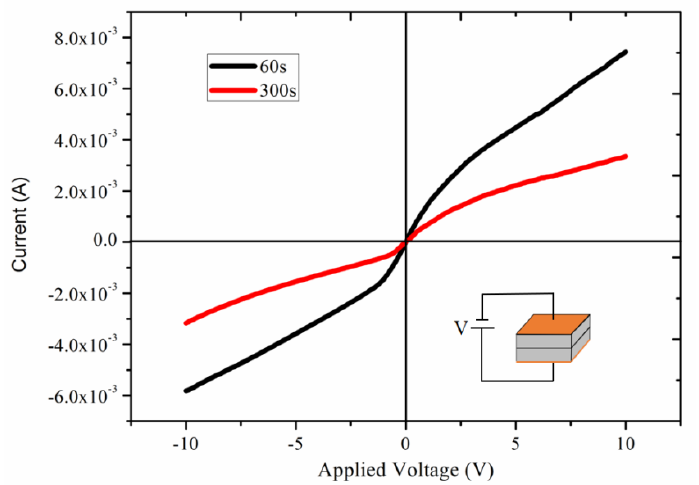
Figure 10. I-V characteristics of Si/Si bonding interface prepared by O 2 plasma activation with activation time of 60 s and 300 s.